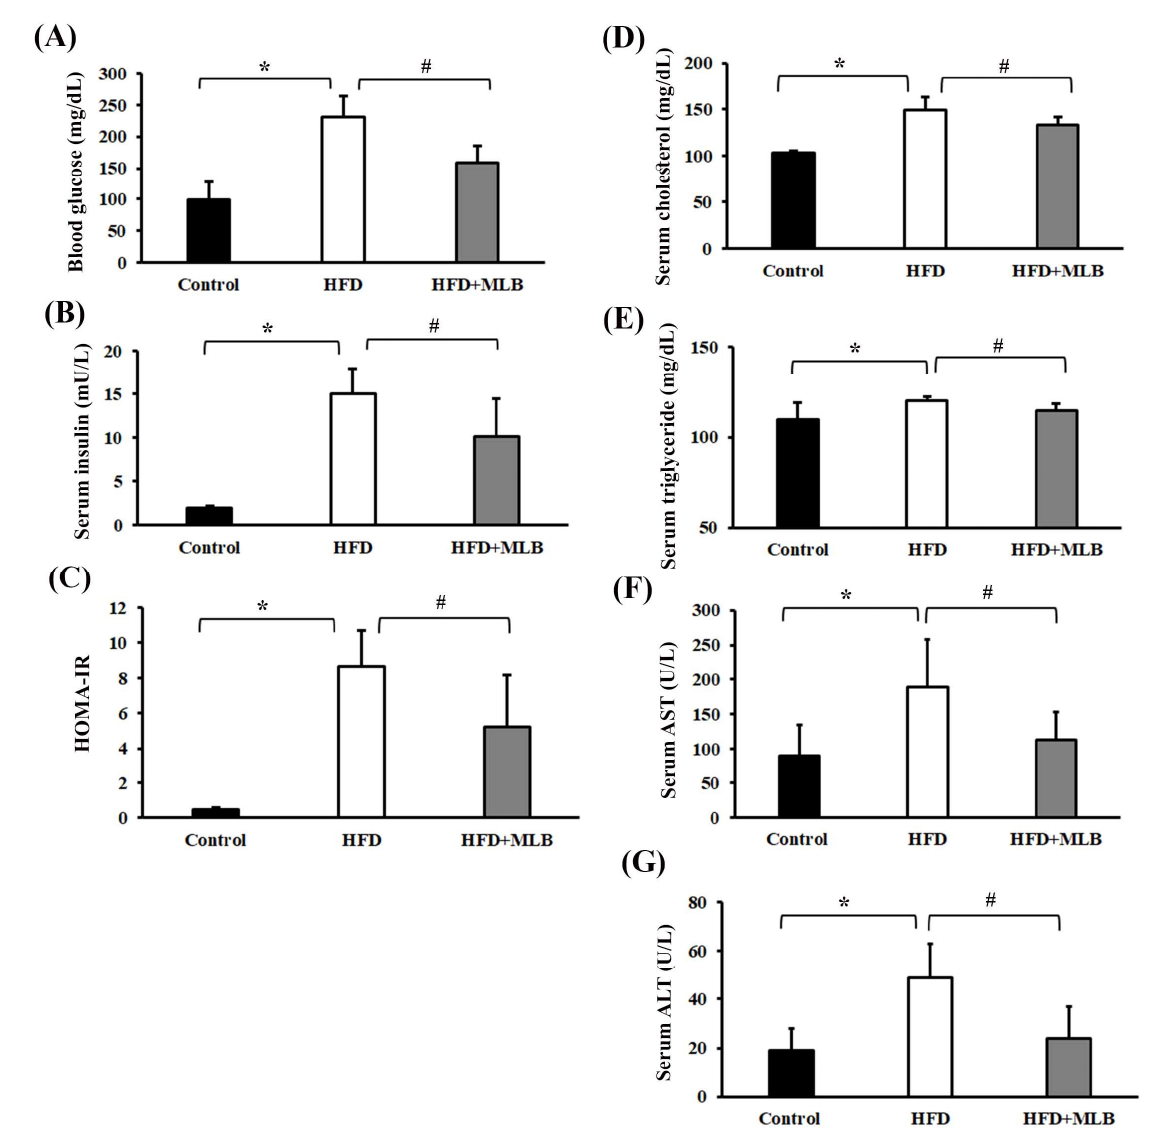
Figure 2. MLB supplementation improved HFD-induced insulin resistance, dyslipidemia, and liver injury. At the end of the experiment, serum samples were subjected to analyses to measure fasting glucose ( A ), insulin ( B ), cholesterol ( D ), triglycerides ( E ), AST ( F ), and ALT ( G ). The value of HOMA-IR is depicted in ( C ). * p < 0.05 vs. control group. # p < 0.05 vs. HFD group. n = 8.